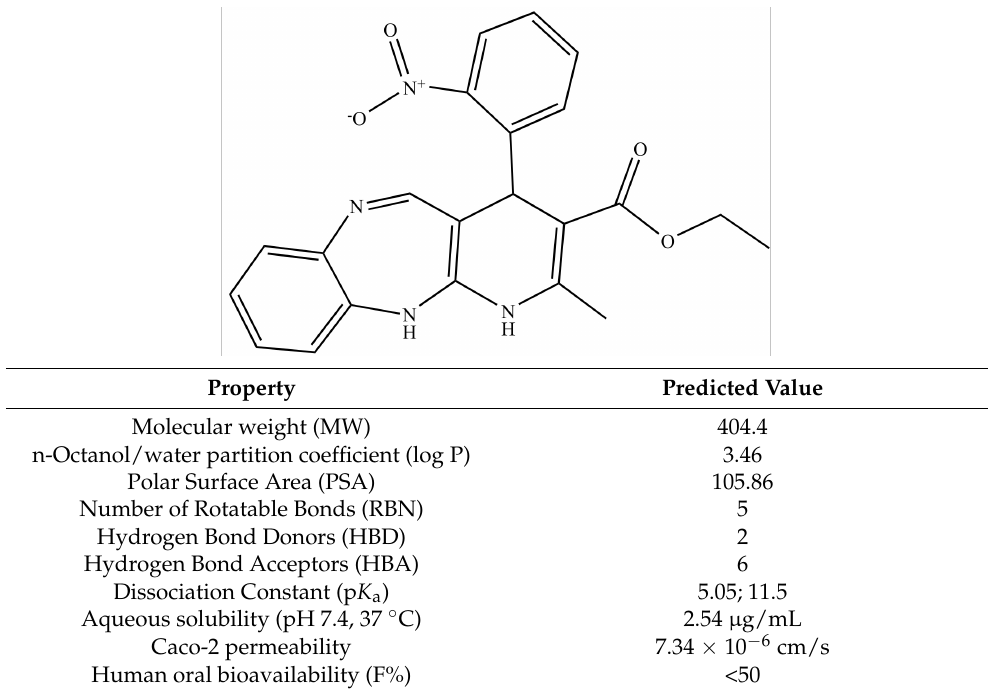
Table 1. Physicochemical and biopharmaceutical predicted properties for